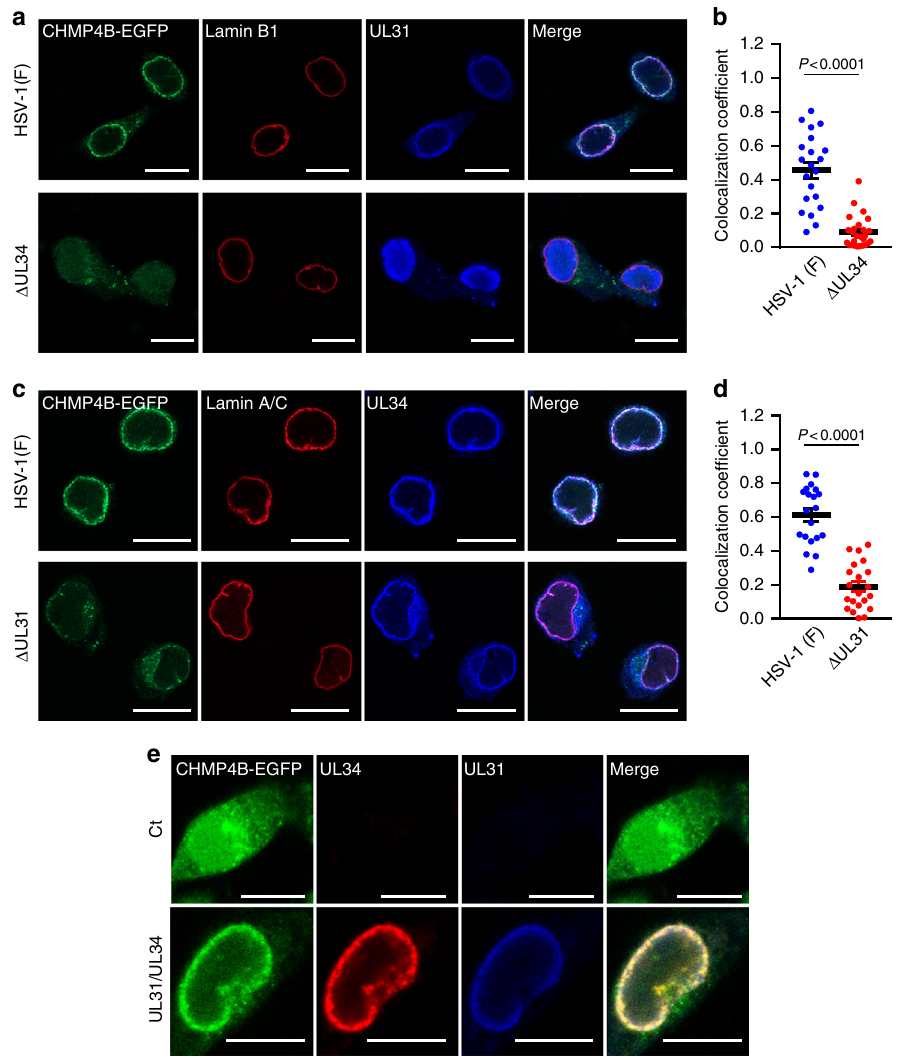
Fig. 2 HSV-1 recruits ESCRT-III via the viral NEC. a Confocal microscope images of HeLa/CHMP4B-EGFP cells infected with wild-type HSV-1 or HSV-1 Δ UL34. Bars, 20 μ m. Images are representative of three independent experiments. b Colocalization between CHMP4B-EGFP and lamin A/C in the experiment in ( a ) was quanti fi ed using Mander ’ s colocalization coef fi cient. Data are shown as the mean ± SEM ( n = 21 for wild-type HSV-1 or 26 for HSV-1 Δ UL34-infected cells and are representative of three independent experiments). c Confocal microscope images of HeLa/CHMP4B-EGFP cells infected